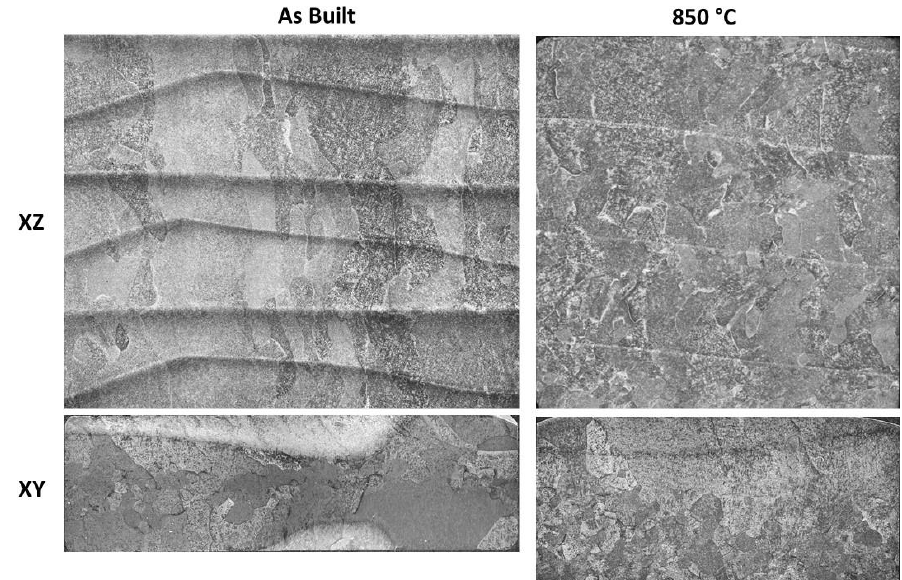
Figure 14. Microstructure observed for the as-built sample, and after the application of a heat treatment at 850 °C in XZ: vertical plane and XY: horizontal plane.